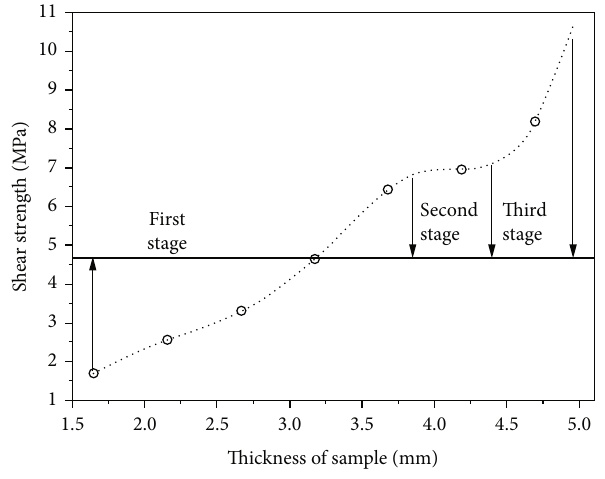
Figure 6: The relationship between specimen thickness and interfacial shear